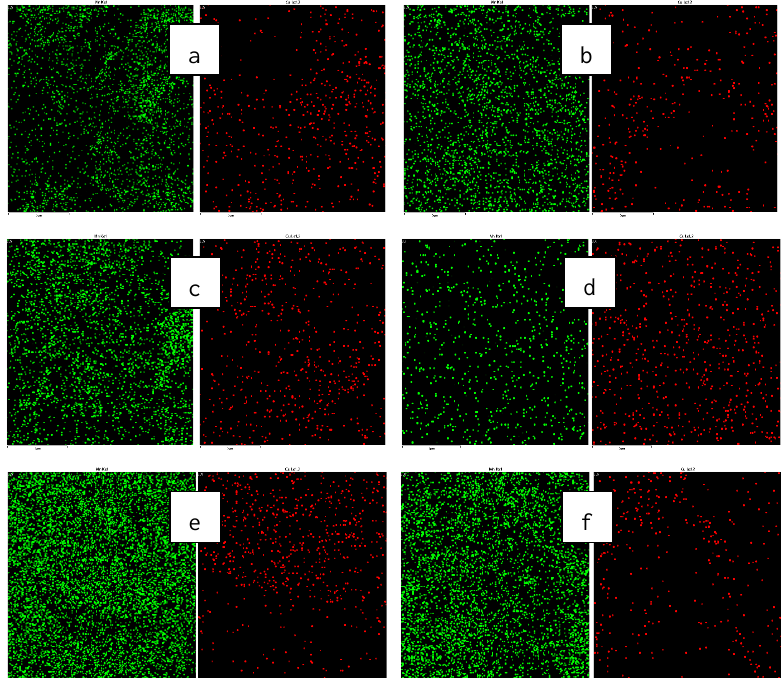
Figure 2. EDX mapping images of the Mn–Cu oxide catalysts supported by the silica gel powder (Mn—green; Cu—red): Mn 90.8 Cu 9.2 /SiO 2 –EMD ( a ); Mn 90.6 Cu 9.4 /SiO 2 –SARA ( b ); Mn 90.9 Cu 9.1 /SiO 2 –WI ( c ); Mn 91.1 Cu 8.9 /SiO 2 –IWI ( d ); Mn 91.1 Cu 8.9 /SiO 2 –UH ( e ) and Mn 89.9 Cu 10.1 /SiO 2 –AE ( f ).